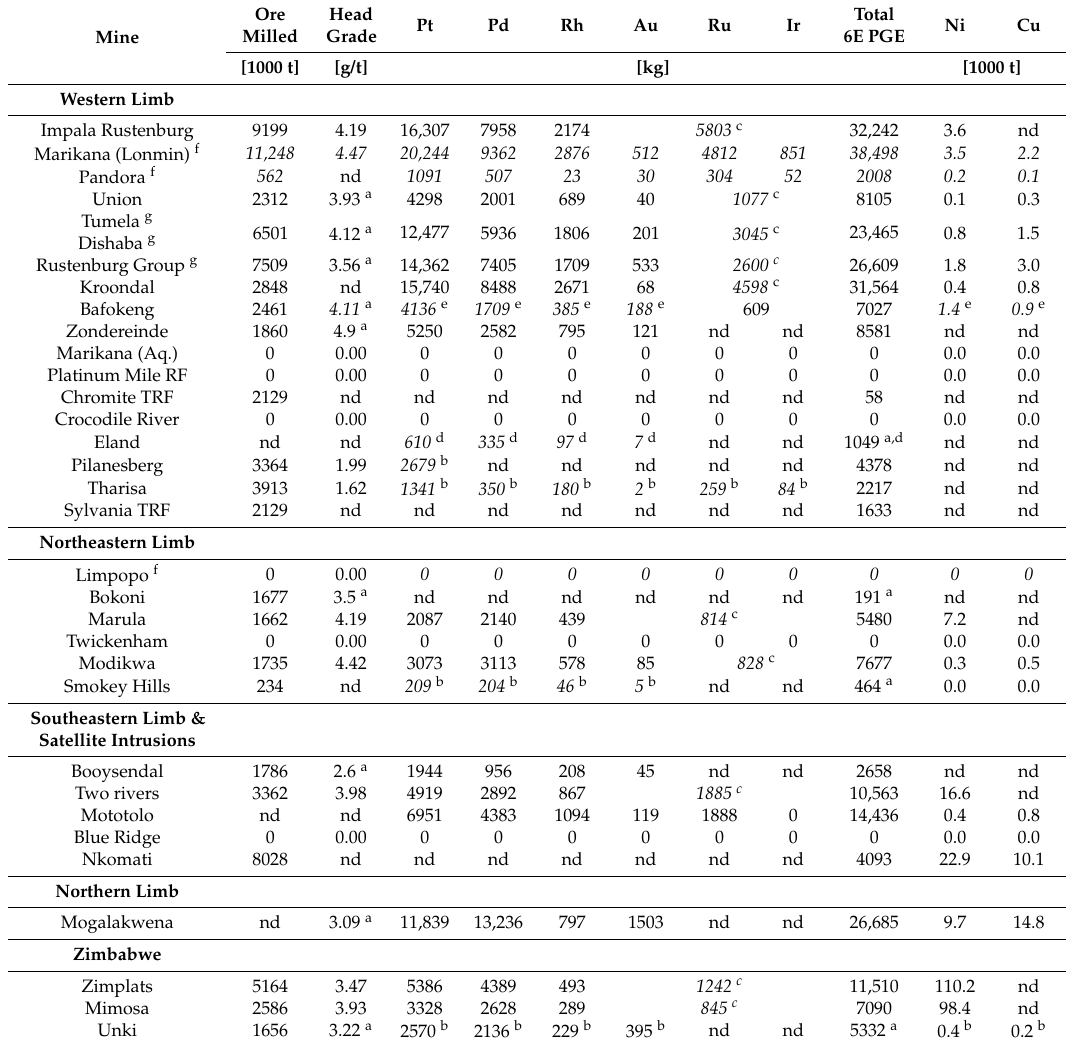
Table 1. Mining data 2015